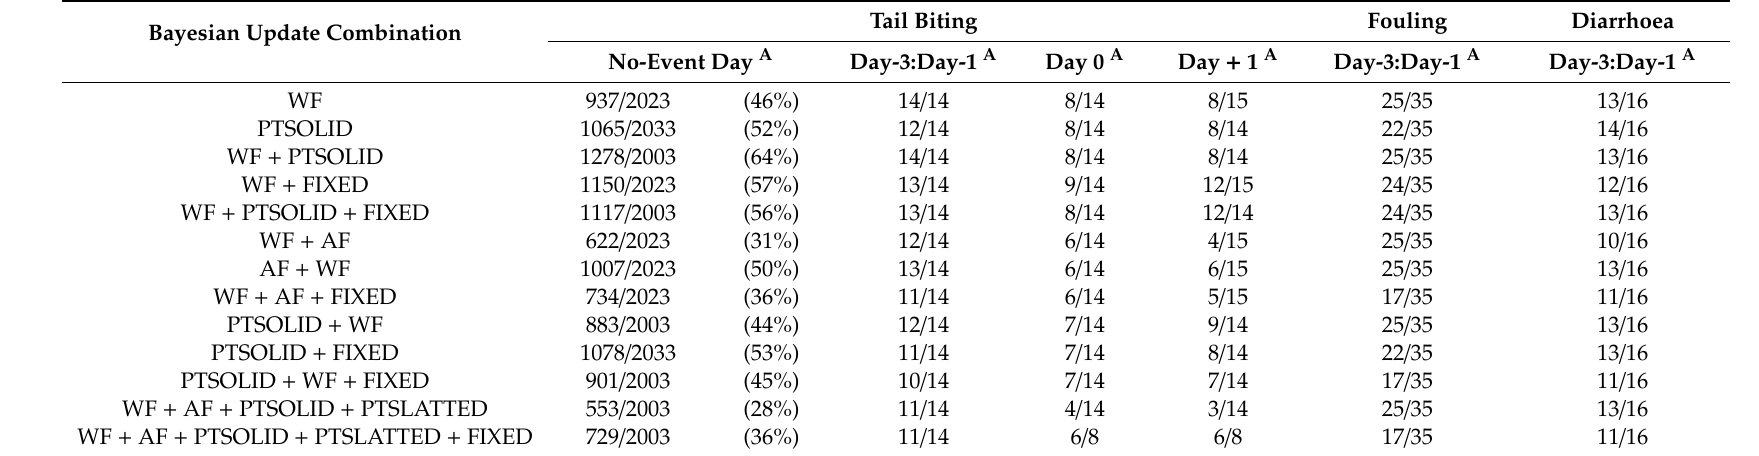
A Results obtained when using the best classification threshold as presented in Table